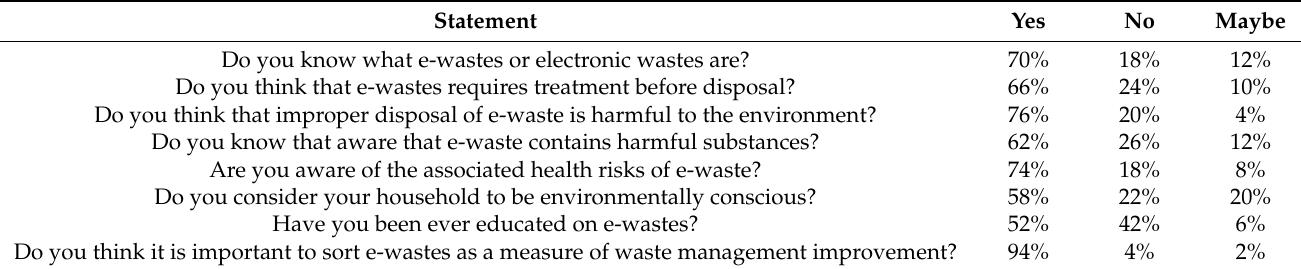
Table 4. Statements on e-waste knowledge and perception by the